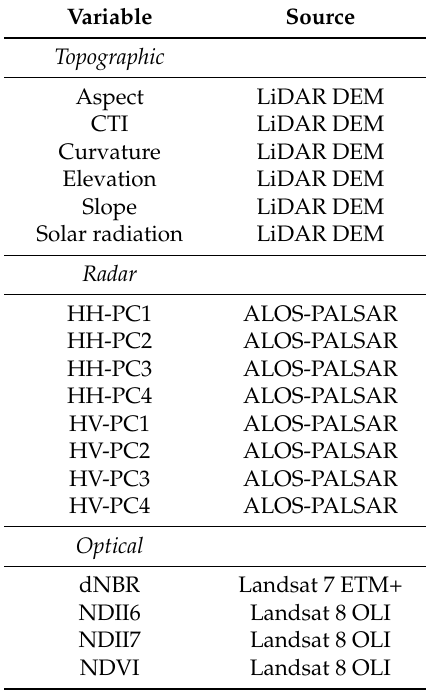
Table 3. Remote sensing variables used in